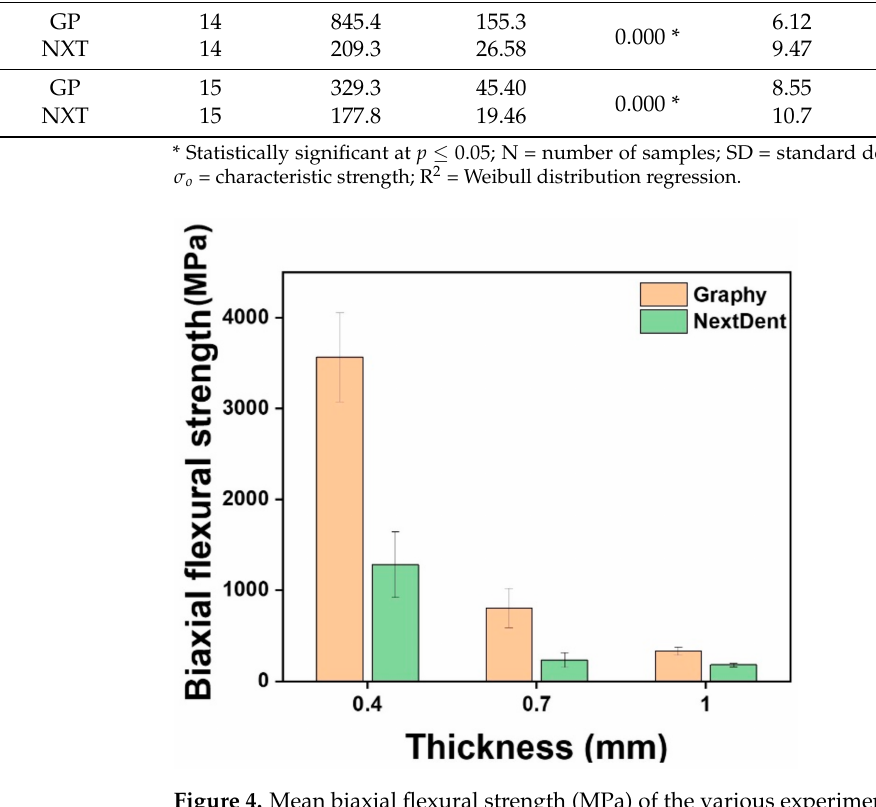
Figure 4. Mean biaxial flexural strength (MPa) of the various experimental